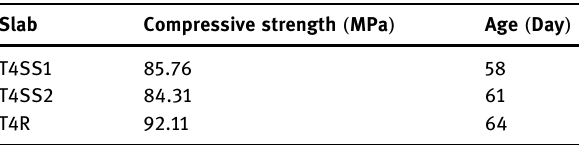
Table 2: Average amounts of three cubes ’ compressive